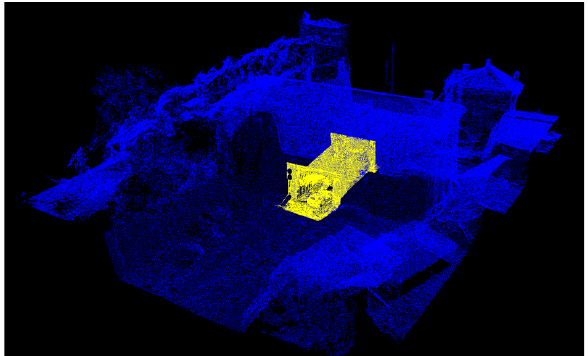
Figure 9. Final point cloud merging the point clouds obtaned by laser scans (yellow) and UAV photogrammetry